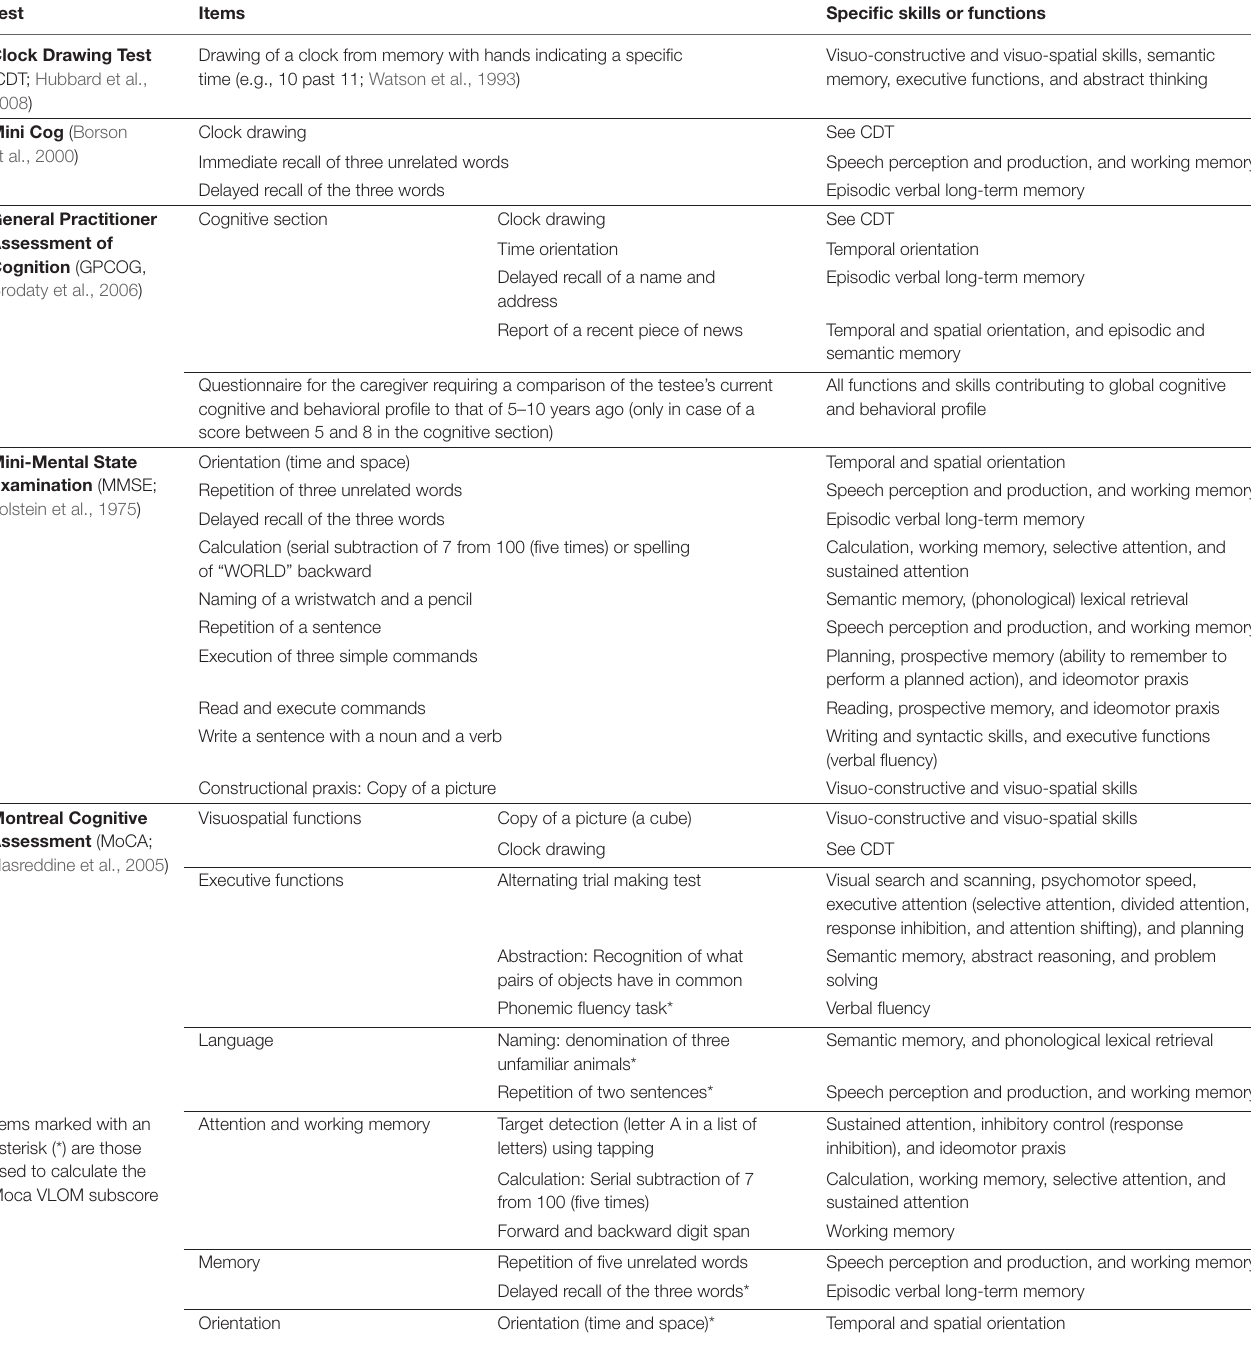
TABLE 1 | Global cognitive tests used in the diagnosis of dementia: sub-scores, items and specific skills or functions required for their correct execution (General skill: Verbal auditory comprehension and working memory). Test Items Specific skills or